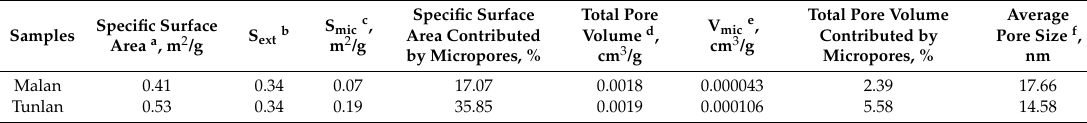
Table 4. Specific surface area and pore volume of Malan and Tunlan samples before